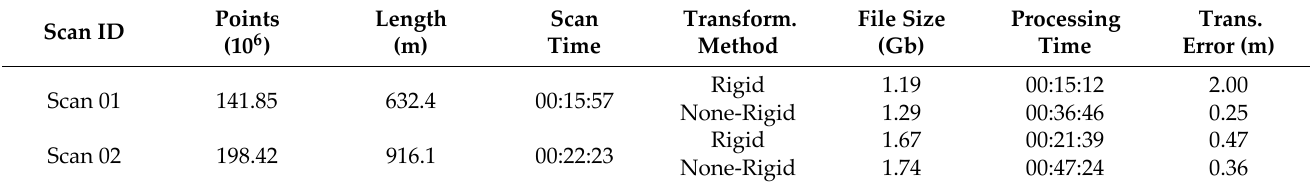
Table 2. Summary statistics of HLS data collection and computing processing time in the lab using Data from point cloud processing in GeoSLAM software. The reported error informed on the mean difference between measured GCP and the coordinate of each point in the processed point cloud.